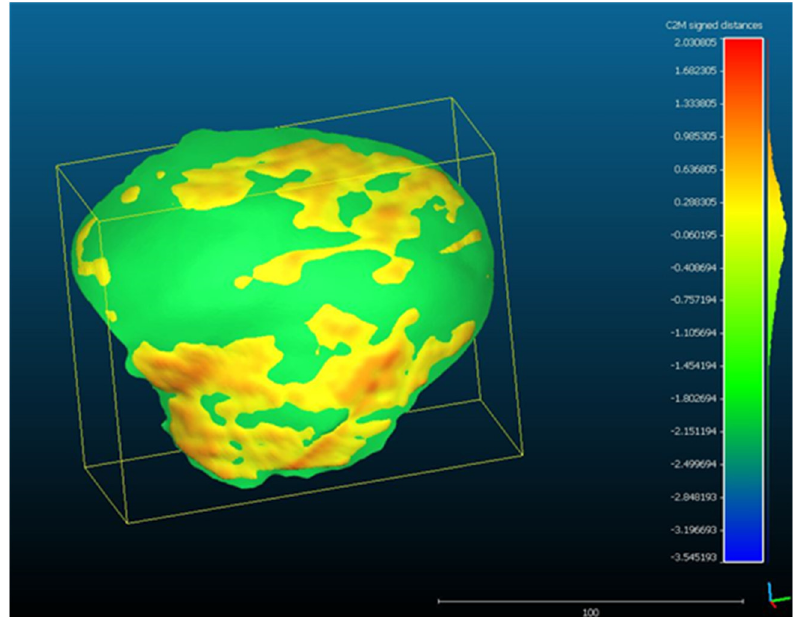
Figure 9. HD for two superimposed patient-specific cranial implants computed using CloudCom- Figure 9. HDfortwosuperimposedpatient-specificcranialimplantscomputedusingCloudComparesoftware. pare software.